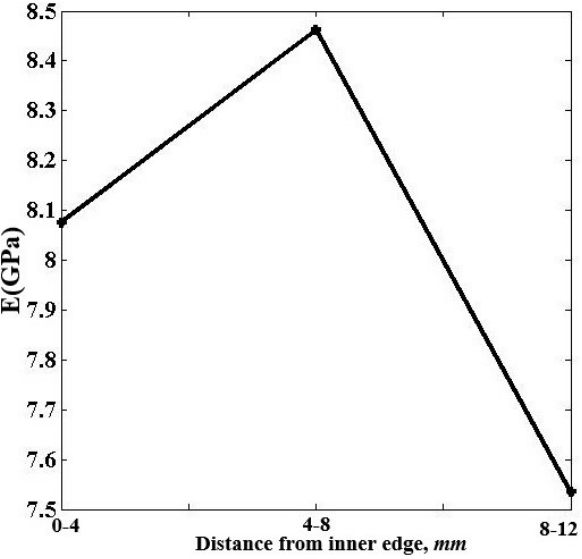
Figure 10: Variation of E along the radial direction from inner to outer walls of thick FGM cylindrical shell